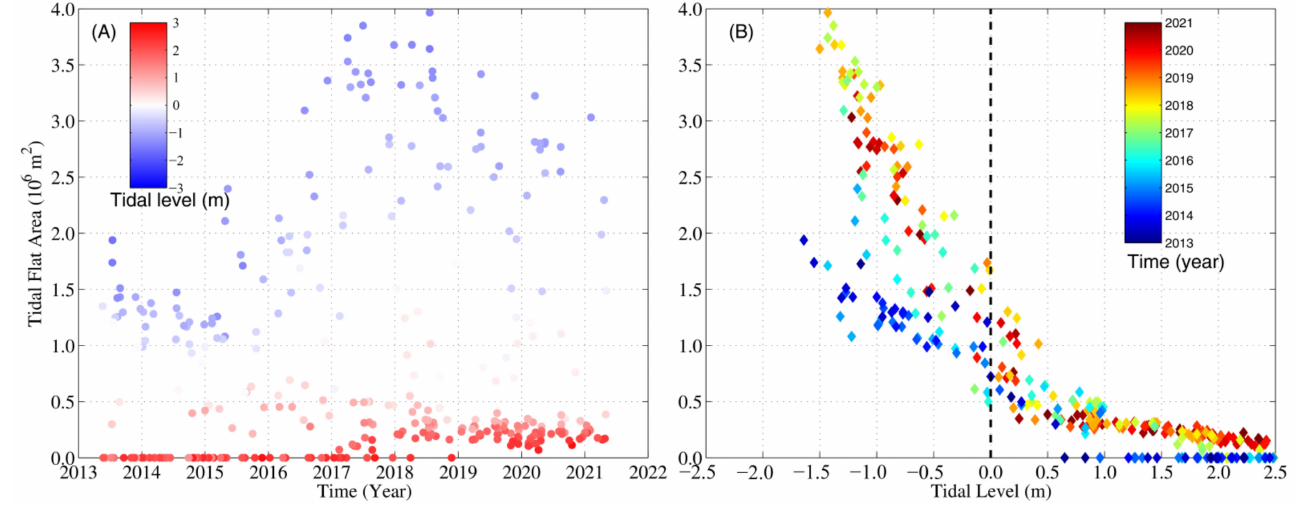
Figure 9. Temporal variations in the tidal flat area (the envelope formed by the waterlines and seawall). ( A ) Variations in the tidal flat area with time. The red and blue dots represent the shorelines at the moments of the high and low tidal levels, respectively. ( B ) The relationship between the tidal level and the tidal flat